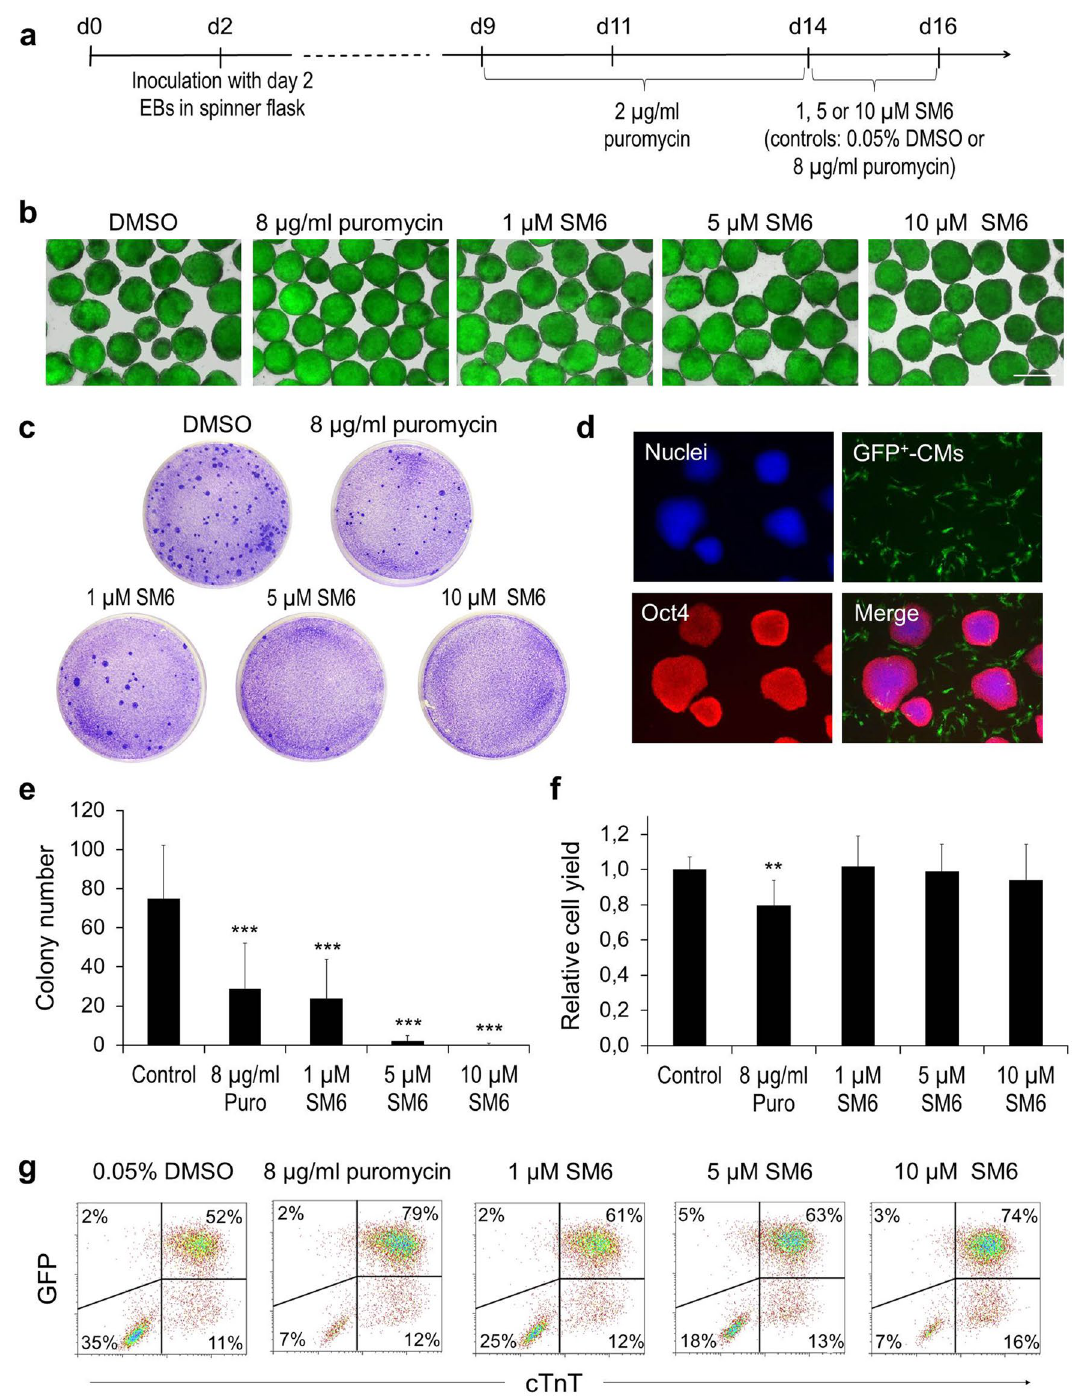
Figure 5. SM6 selectively eliminates undifferentiated PSCs in partially purified miPSC-CMs generated in suspension cultures as cardiac clusters. ( a ) Time course of αPIG-AT25 miPSC cardiogenic differentiation and drug treatment. ( b ) Representative bright field and GFP-fluorescence images (overlay) of miPSC-derived GFP-expressing cardiac clusters from day 16 of differentiation after 2 day treatment with indicated drugs. Scale bar: 100 µm. ( c ) Representative images of crystal-violet-stained PSC-colonies (dark blue spots) formed after growing 2 × 10 5 cells derived from day 16 cardiac clusters in one 6 cm plate for 7–10 days in mPSC culture conditions. ( d ) Oct4 expression (red) confirms the PSC identity of colonies detected by crystal violet in panel C. ( e ) Quantification of PSC-colonies per 2 × 10 5 cells/plate seeded as described in panel C (mean ± SD; n = 19 from five independent experiments). *** p < 0.001. ( f ) Total yield of cells harvested from day 16 cardiac clusters after treatment with indicated drugs. Results are shown as relative values compared to DMSO-treated control (mean ± SD; n = 9 from five independent experiments). ** p < 0.01. ( g ) Flow cytometric analysis of GFP-expressing day 16 CMs treated with indicated reagents and stained for cardiac troponin T (cTnT) in one representative differentiation experiment. See also Supplementary Fig.